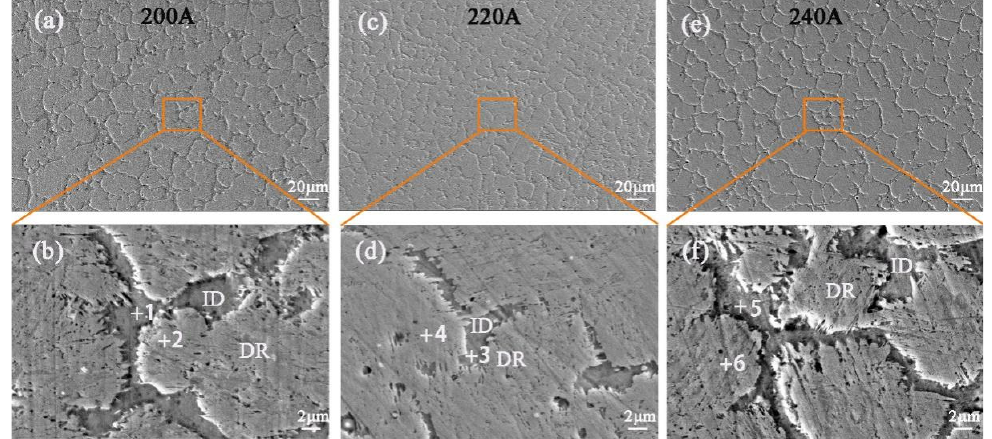
Figure 3. ( a , c , e ) show the SEM of the top of FeCrMnCuNiSi 1 high-entropy alloy coating at melting currents of 200 A, 220 A, and 240 A, respectively. ( b , d , f ) show the enlarged views of the orange rectangular areas in ( a , c , e ). Table 1. EDS of the microstructure of the top region of the FeCrMnCuNiSi 1 high-entropy alloy coating at different melting currents. Coating